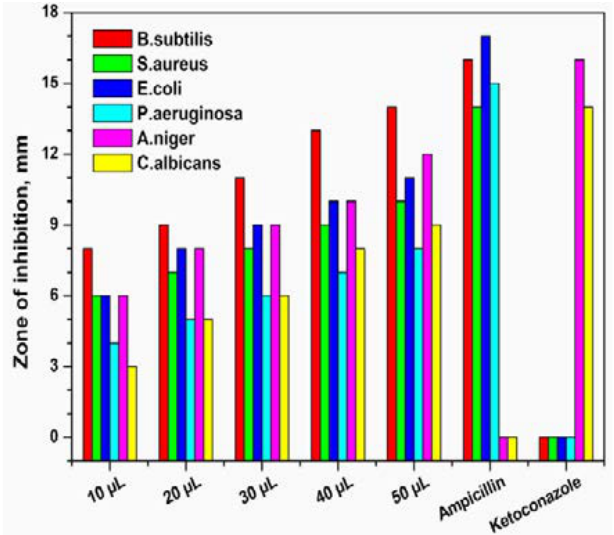
Fig. 13: The antibacterial and antifungal activity of the different amounts (10 µL to 50 µL) of synthesized Ir-doped TiO